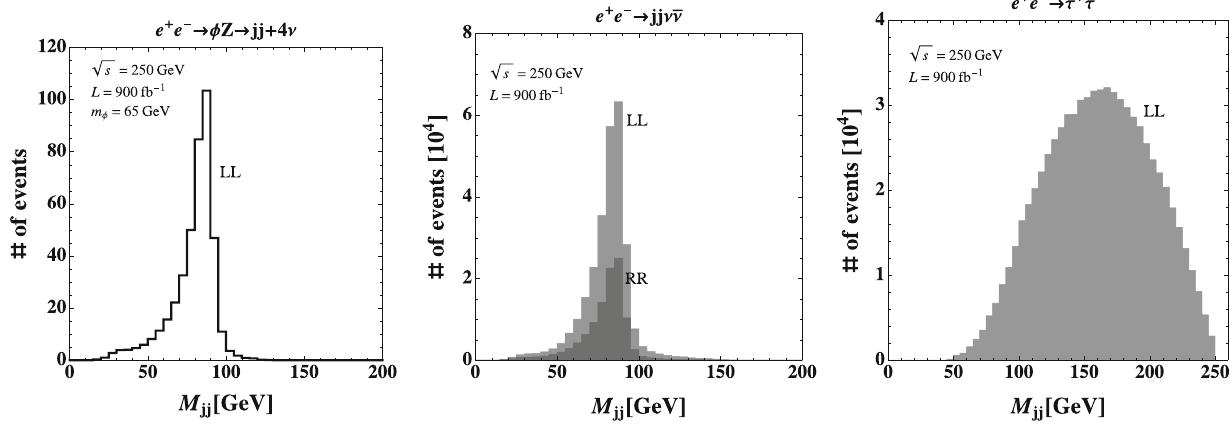
Fig. 8 Distribution of invariant mass for two jets with only basic cuts where left-, middle- and right-panels correspond to signal, jj ν ¯ ν BG and τ + τ − BG events. Here κ α = 1 is